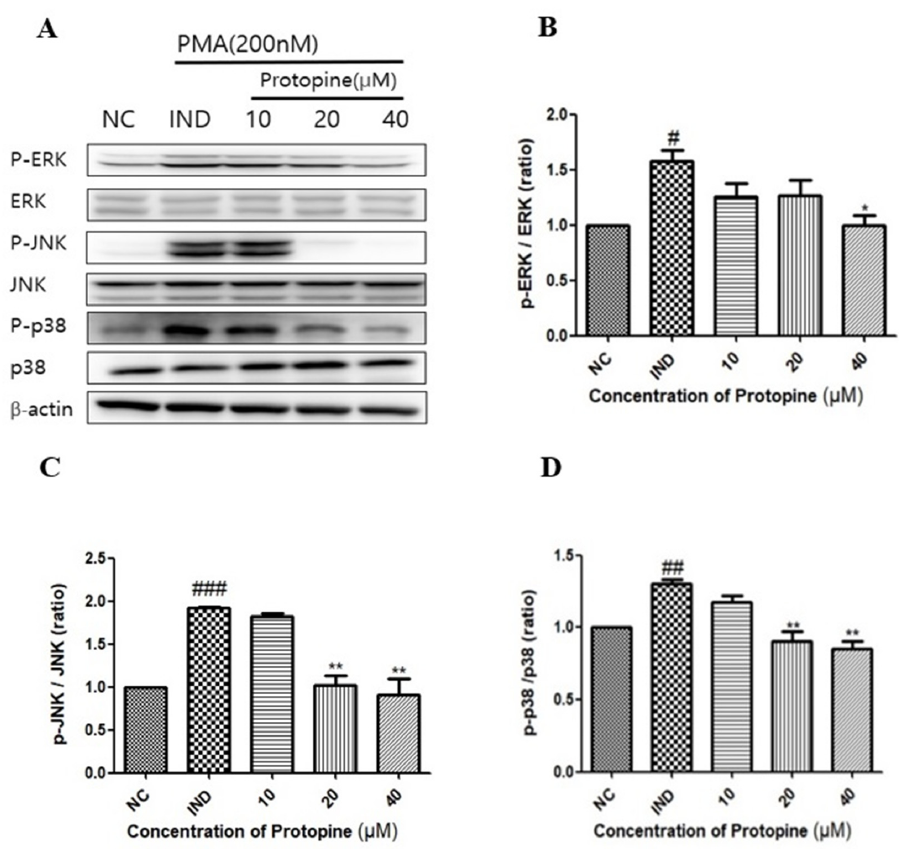
Figure 5. Protopine PMA-stimulated MAPK activity in HepG2 cells. ( A ) Levels of MAPK expression determined by Western blot. ( B ) ERK1/2 activated by PMA inhibited its activation in a concentration-dependent manner on protopine. ( C ) Protopine inhibited JNK activation in a concentration-dependent manner. ( D ) Protopine suppressed the activity of p38 to a high level when treated with 40 µ M. The results are presented as mean ± SD. # p < 0.05 ## p < 0.01, and ### p < 0.001 indicate significant differences from the control group. * p < 0.05, ** p < 0.01, indicating a significant difference from the PMA group.